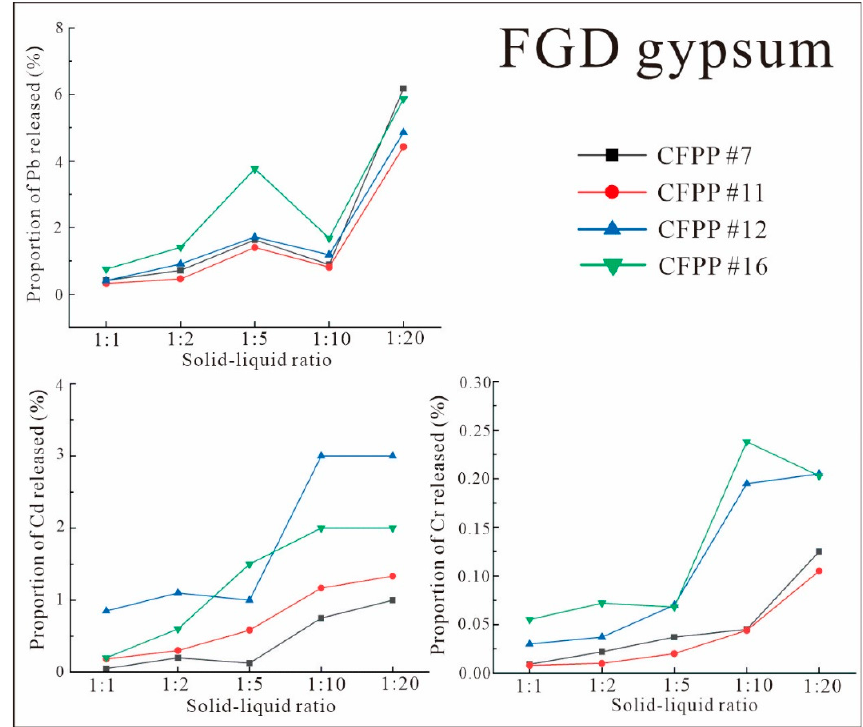
Figure 8. Heavy-metal release fractions from FGD gypsum with various solid-to-liquid ratios.